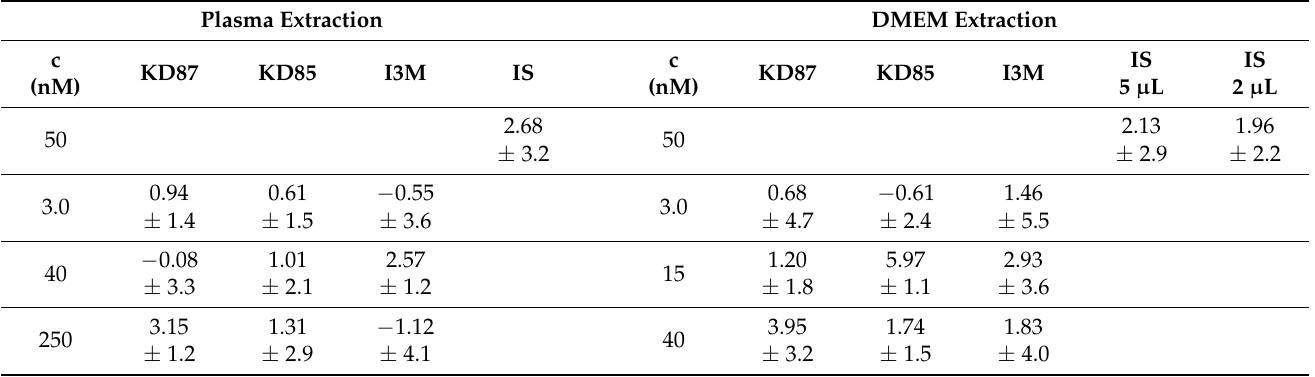
Table 6. Matrix effect for analytes KD87, KD85, I3M, and internal standard (IS) after plasma extraction or DMEM extraction. Values are mean percentages ± standard deviation (SD) of n =